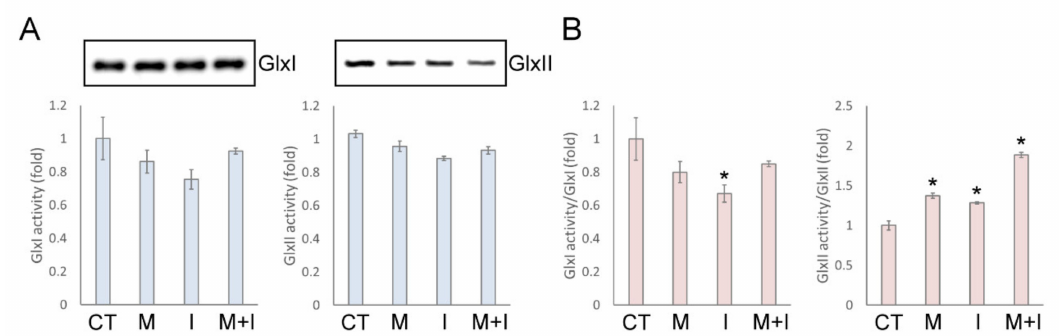
Figure 2. The individual activity and protein levels of glyoxalase system under insulin and metformin treatment. ( A ) The activity and enzyme expression level, and ( B ) normalized activity of glyoxalase 1 (GlxI) and GlxII of whole cell lysates from insulin- and metformin-treated HEK293T cells. Results significantly different from control at p < 0.05 are indicated by * ( n =